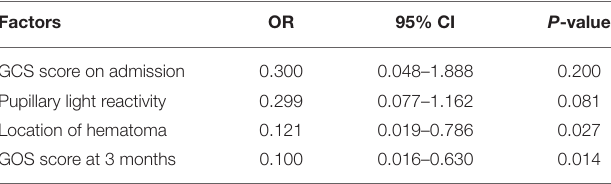
TABLE 2 | Multivariate logistic regression model for factors associated with swirl sign.